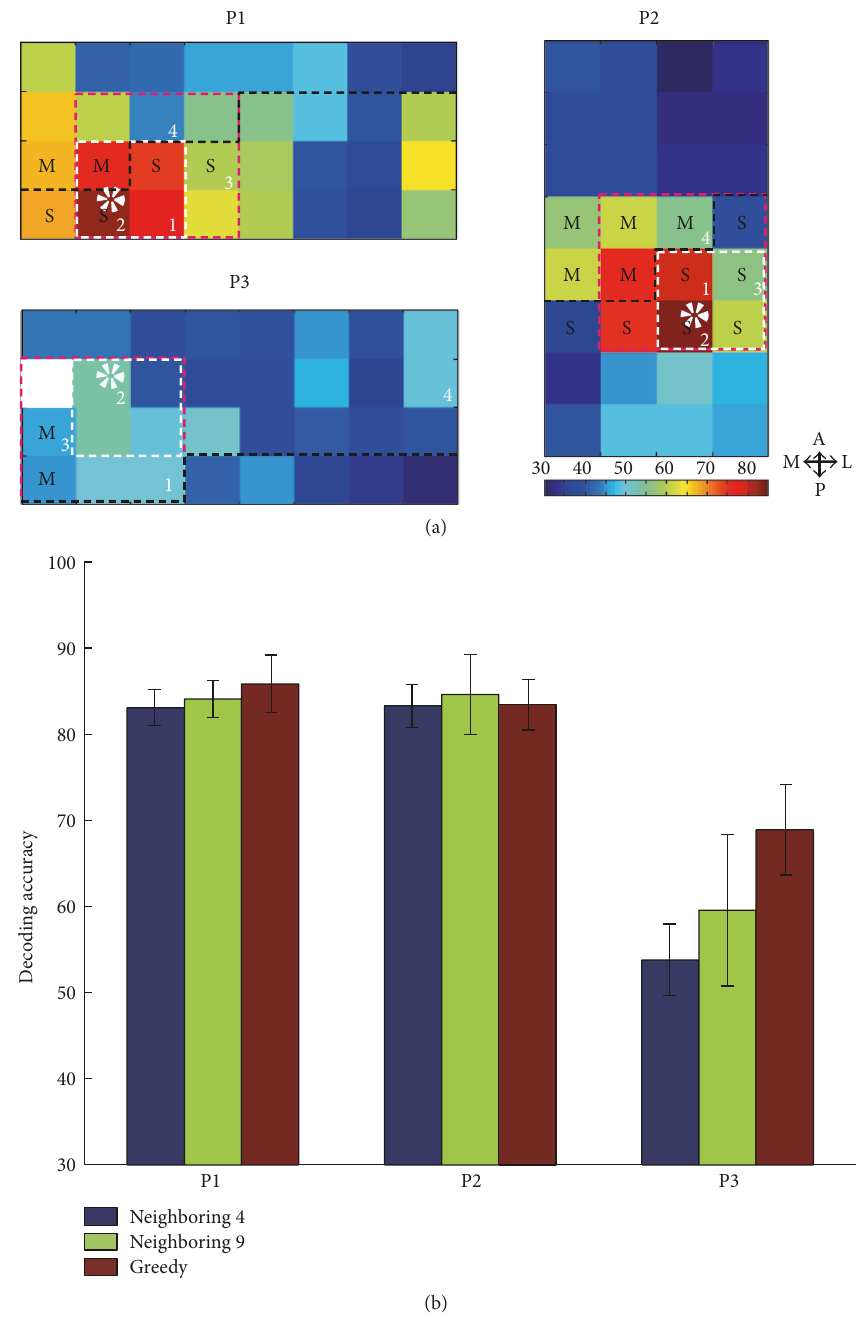
Figure 6: Topographies of decoding performance using neighboring 4 channels and the decoding performance comparison of di ff erent channel selection strategies (neighboring 4, neighboring 9, and greedy) of all participants. (a) The color of each cell indicates the decoding performance using the recordings from neighboring 4 channels. The color bars give the scale of decoding performance. The white dashed outline marks out the channels with the highest decoding performance (marked with a white dashed circle), and the red dashed outline marks out the neighboring 9 channels. Black dash line represents the central sulcus. (M =motor, S =sensory). (b) The decoding performance with optimal channel subsets using di ff erent channel selection strategies of all the three